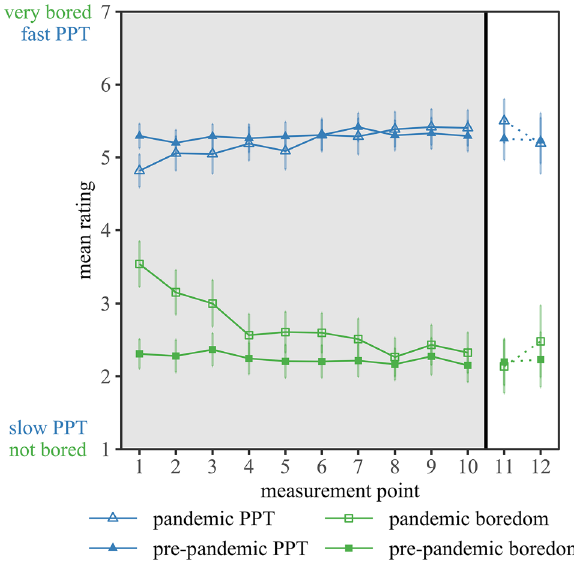
Figure 1. Mean ratings for the perceived passage of time (PPT) and boredom, both before ( pre-pandemic ) and during the pandemic as a function of measurement points. The main study included measurement points 1–10 (gray background). The follow-up study included measurement points 11 and 12 (white background). Error bars show 95% confidence intervals.